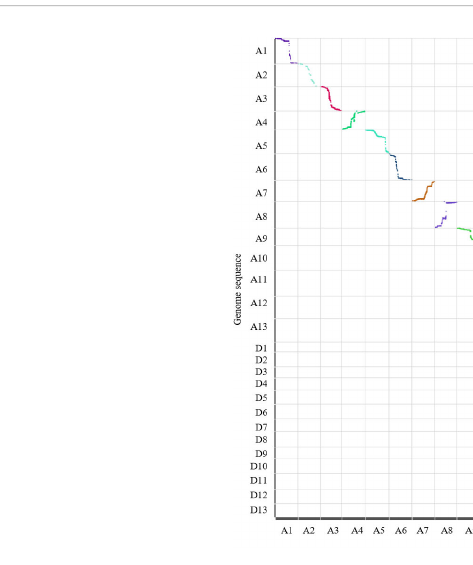
FIGURE 2 Colinearity analysis between the genetic map and reference genome sequence.